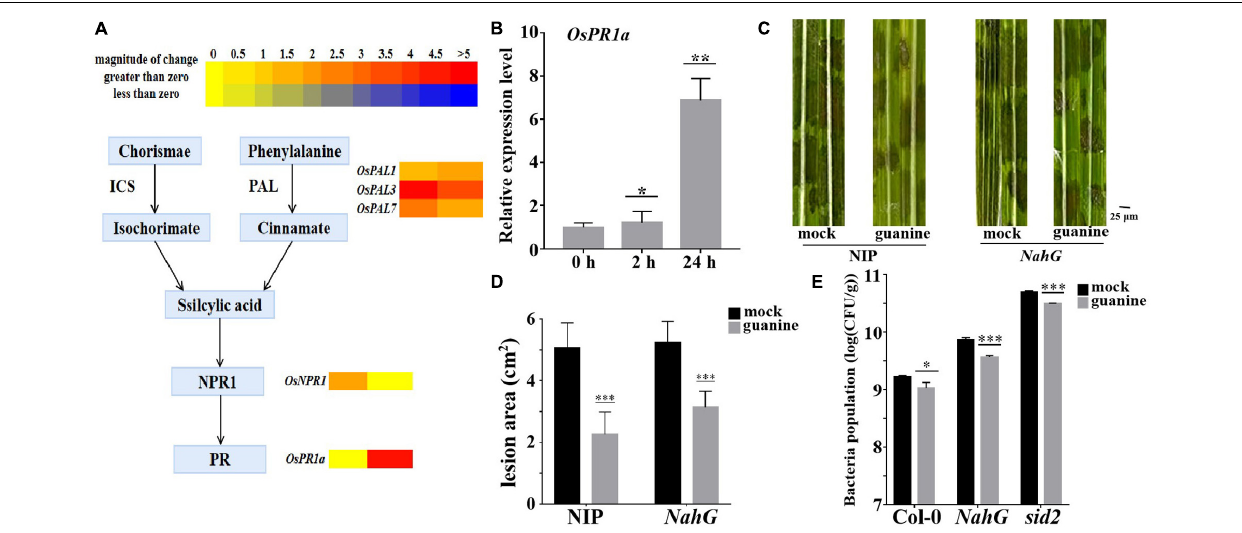
FIGURE 6 | Guanine upregulated the expression of SA signaling pathway genes but still enhanced plant disease resistance in SA-deficient mutant plants. (A) Heatmap analysis of SA biosynthesis and responsive gene expression after guanine treatment at 2 and 24 hpt. (B) qRT-PCR for the detection of the SA pathway gene OsPR1a. The horizontal coordinates indicate the time of guanine- and mock-treated rice, and the vertical coordinates indicate the relative gene expression levels of guanine compared to the mock at the same time point. Asterisks indicate P < 0.05 (*), P < 0.01 (**) in Student’s t -test analysis. (C) Disease symptoms of the NahG transgenic plants. Leaves of the rice plants treated with the mock and 100 ng/mL guanine prior to R. solani strain YWK196 inoculation. The disease symptoms were photographed at 3 dpi. (D) Measurement of the lesion area of (C) by ImageJ. Asterisks indicate P < 0.001 (***) in Student’s t -test analysis. (E) Bacterial population in Col-0, NahG and sid2 plant leaves. Arabidopsis leaves treated with the mock and 100 ng/mL guanine prior to Pst DC3000 inoculation. Bacterial population was calculated at 3 dpi. Asterisks indicate P < 0.05 (*), P < 0.001 (***) in Student’s t -test analysis.